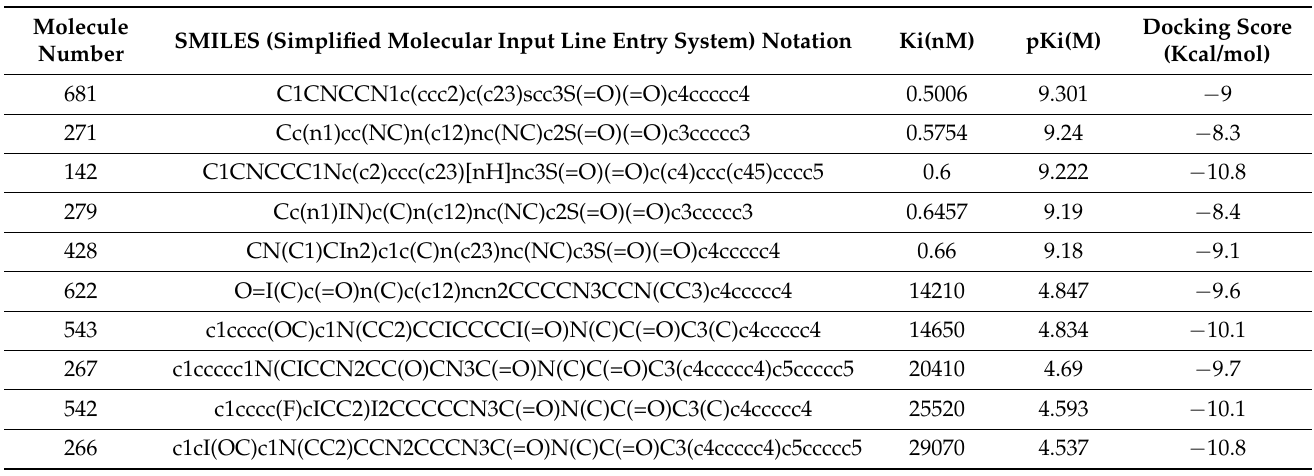
Table 4. SMILES (simplified molecular input line entry system) notation, Ki (nM), pKi (M), and molecular docking score for the five most and five least active molecules of the selected